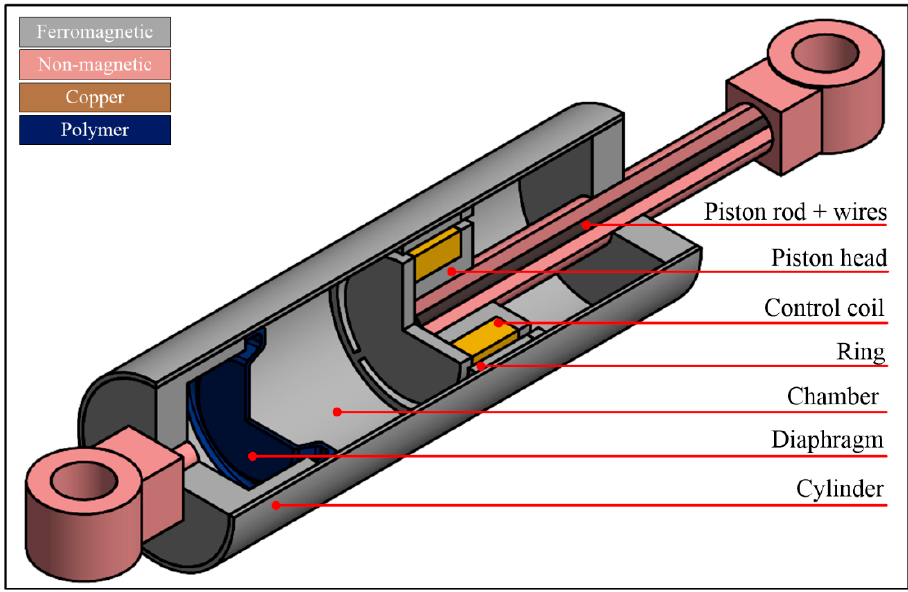
Figure 3. MR damper structure.